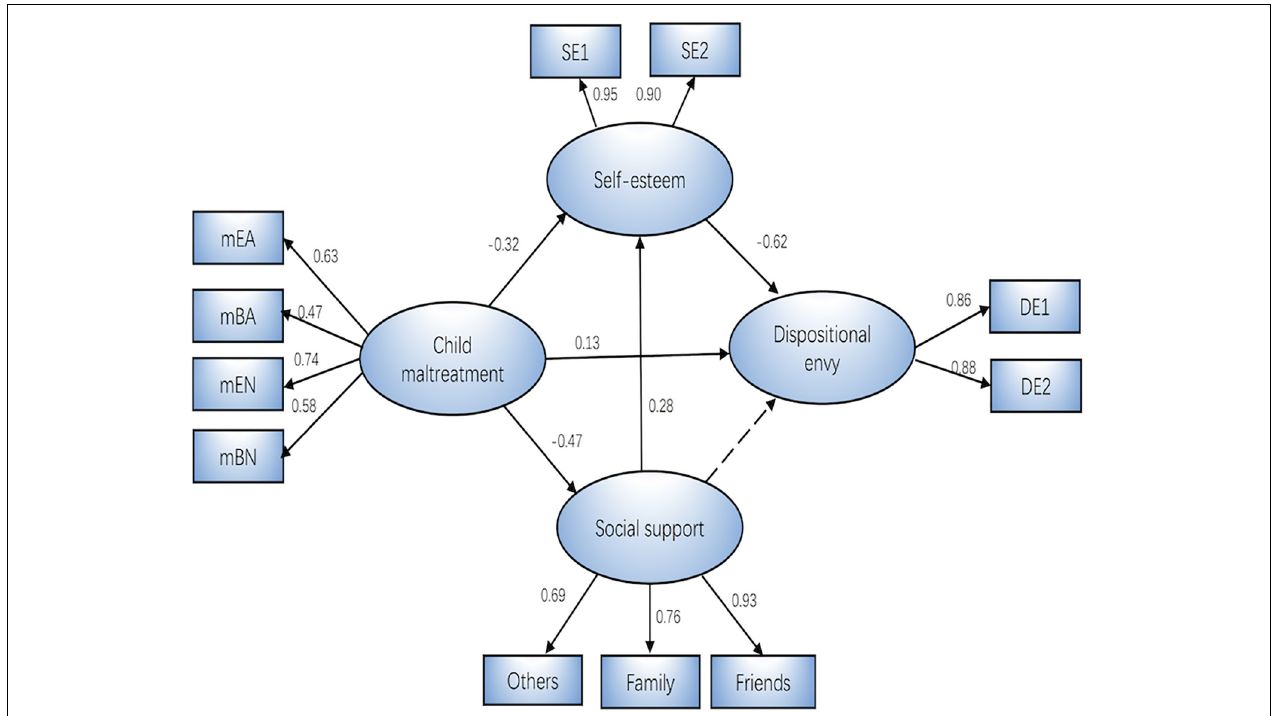
FIGURE 1 | The mediation model ( N = 426). Factor loadings are standardized. SE1 and SE2 are two parcels of the Rosenberg Self-Esteem Scale; DE1 and DE2 are two parcels of the Dispositional Envy Scale; Others, Family, and Friends are the subscales of the Multi-Dimensional Scale of Perceived Social Support, which are